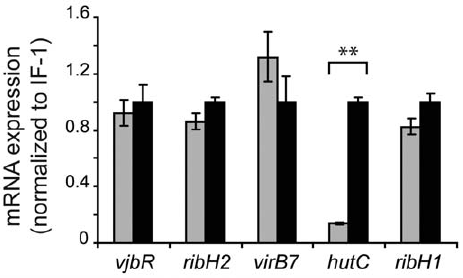
Figure 6. Quantitative real-time PCR analysis of the effect of urocanic acid on gene expression. Strain B. abortus 2308 was grown in TSB and shifted to MM1 at pH 5.5, in the absence (gray bars) or presence (black bars) of 5 mM urocanic acid. Subsequently, total RNA was isolated and processed for quantitative real-time PCR to analyze the levels of vjbR , ribH2 , virB7 , hutC , and ribH1 transcripts. Values are expressed as relative mRNA fold differences between treatments with (black bars) or without (gray bars) 5 mM urocanic acid, indicating means 6 standard deviations of duplicate samples from a represen- tative of two independent experiments. **, P , 0.01.